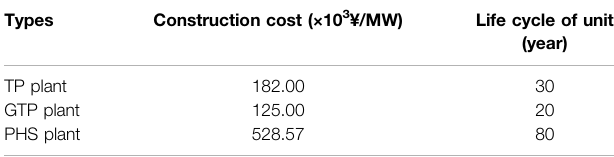
TABLE 1 | Unit construction cost and life